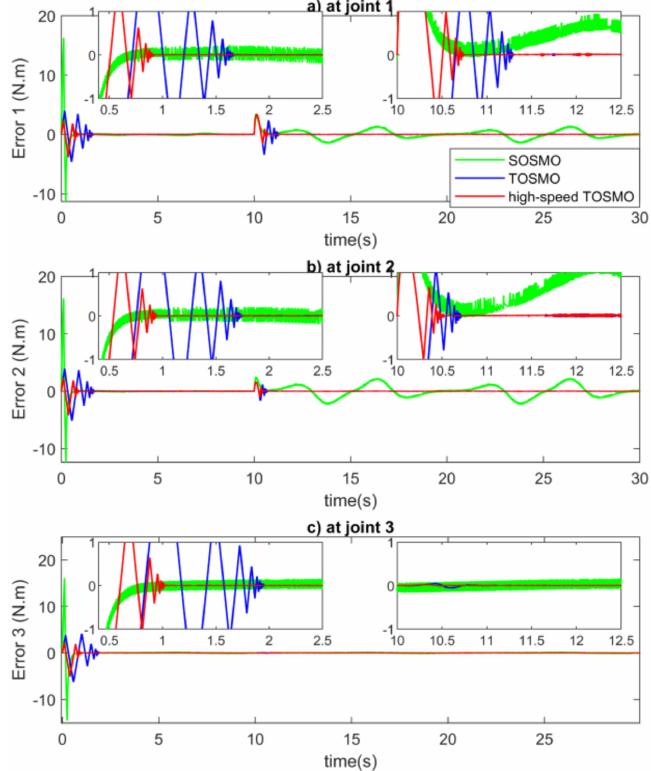
Figure 5. Lumped unknown input estimation errors at ( a ) joint 1, ( b ) joint 2 and ( c ) joint